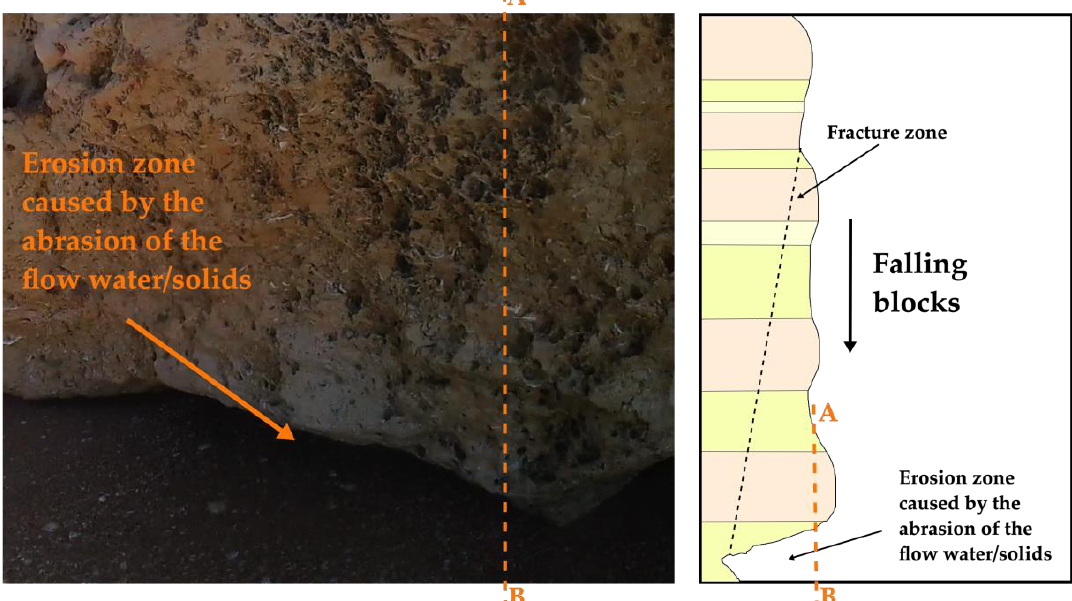
Figure 12. Location of the abrasion zone caused by sea undulation with the sediments being dragged against the rocky surface of the cliff, causing mechanical erosion of the rock.